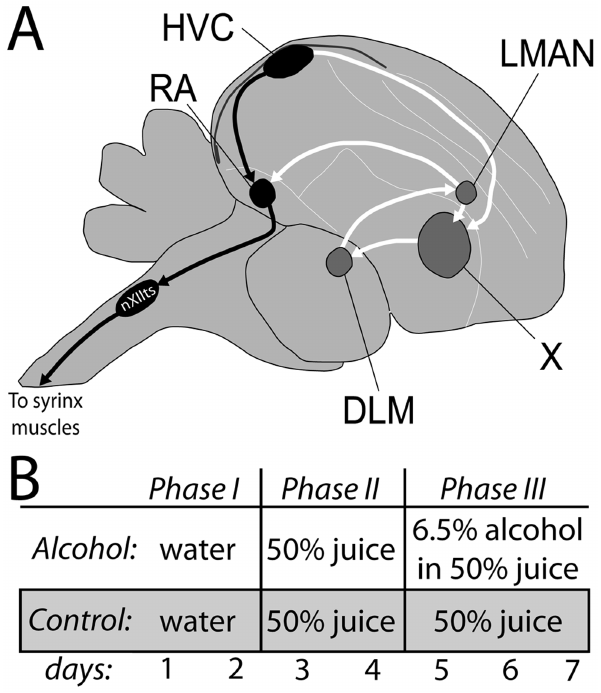
Fig. 1. The finch song system and experimental paradigm. (A) The neuronal song system consists of a posterior vocal motor pathway (black): pre-motor cortical nucleus HVC projects to motor nucleus RA (robustus of the arcopallium), which projects to brainstem medullary nXIIts respiratory and vocal (syrinx) motor neurons, and the anterior pathway (white): HVC (a proper name), which projects to striatal Area X (X), and from there, sequentially to thalamic nucleus DLM (dorso-lateral division of the medial thalamus), to cortical nucleus LMAN (lateral magnocellular nucleus of the nidopallium) and to RA. (B) The study design assigned adult male finches to alcohol or control drinking treatments. They were then taken through three sequential Phases where they were provided with water (Phase I), 50% juice (Phase II), and alcohol in juice or juice only (Phase